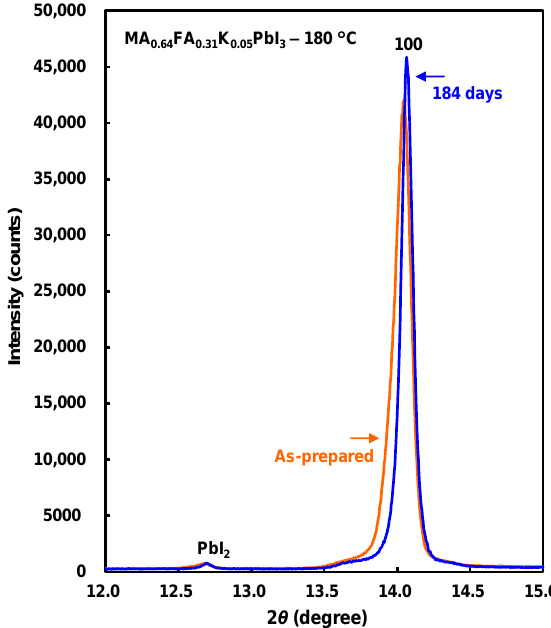
Figure 5. Comparison of the XRD patterns of the MA 0.64 FA 0.31 K 0.05 PbI 3 devices as a function of time, prepared at 180 °C for 10 min.